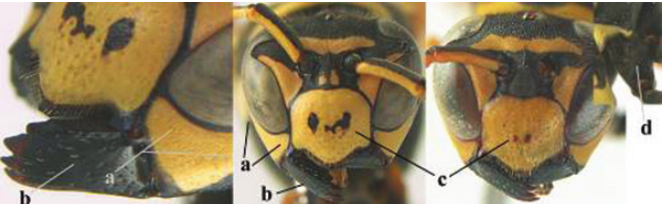
Malar space mainly yellow and connected to yellow ventral part of temple (a); mandible usually black (b), if mandible with yellow patch then total yellow area smaller than yellow area of malar space and temple; clypeus somewhat wider than high medially (c); hind coxa black dorsally (d); dominula -group ............ 10